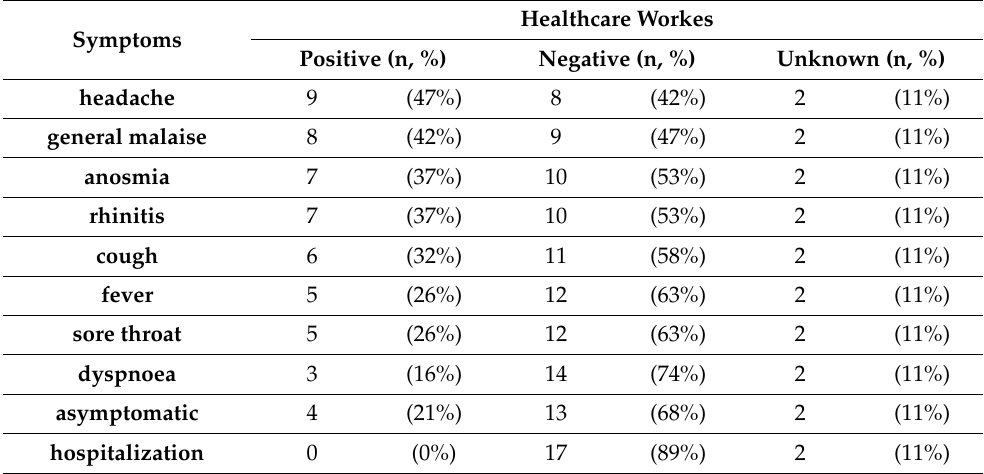
Table 2. Symptoms of healthcare workers who tested positive for SARS-CoV-2 IgG antibodies; n